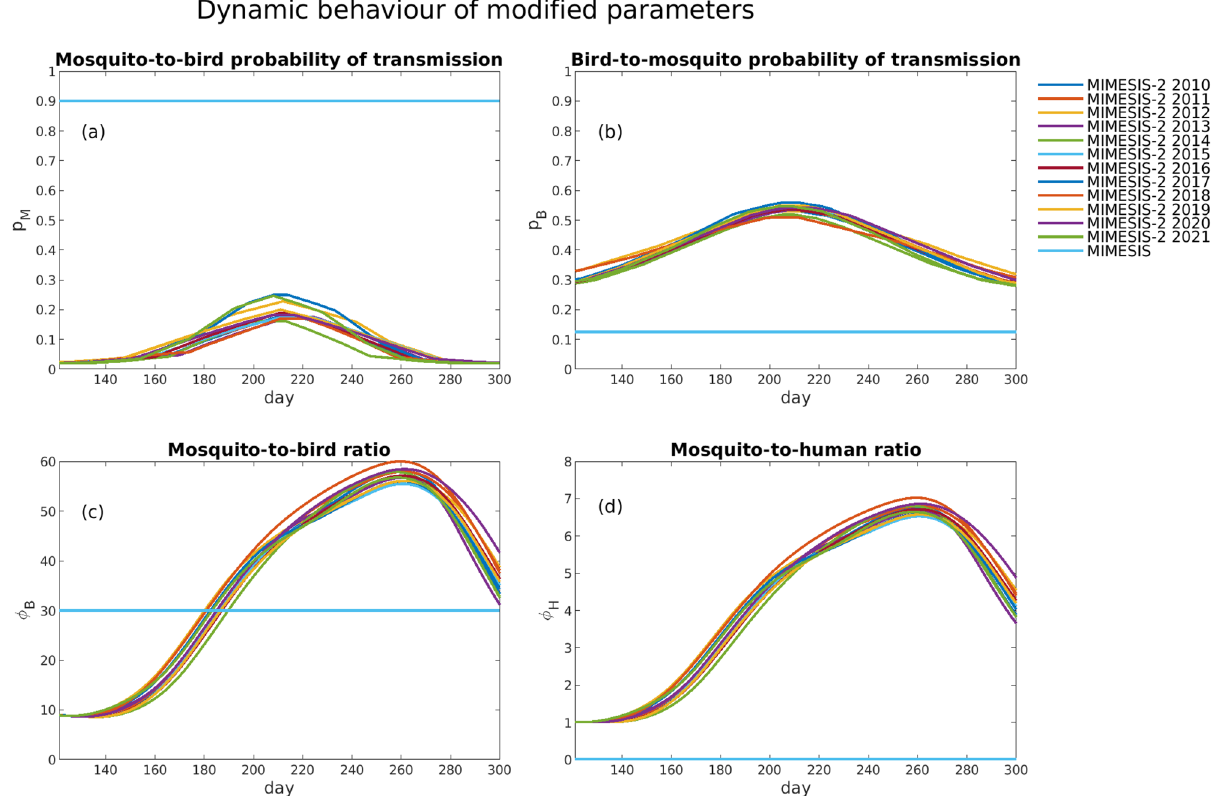
Figure 3. The temporal evolution during May to October of the ( a ) mosquito-to-bird probability of transmission, p M , ( b ) bird-to-mosquito probability of transmission, p B , ( c ) mosquito-to-bird ratio, ϕ B , and ( d ) mosquito-to-human ratio, ϕ H , for both MIMESIS-2 across different years and MIMESIS for each of the 12 years from 2010 to 2021. The plots refer to the simulations for the municipality of